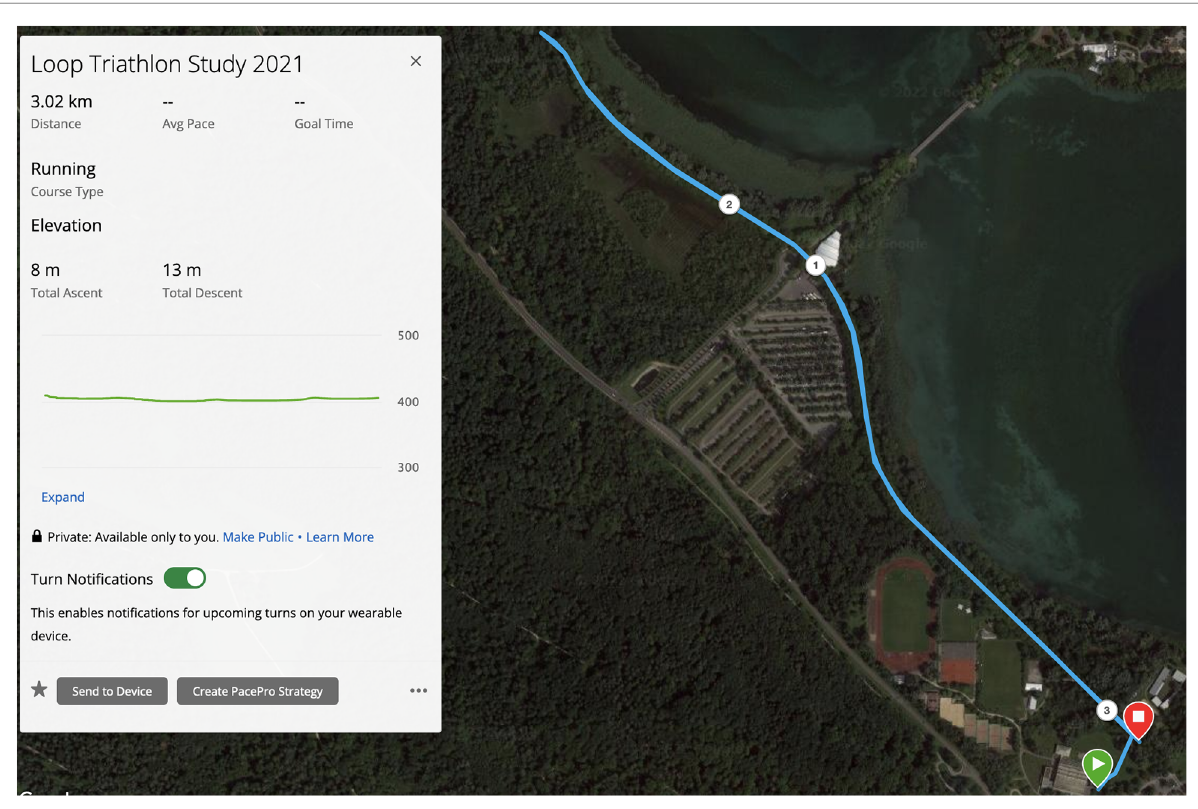
FIGURE 1 Running course map (extracted from Garmin Connect App, GARMIN,